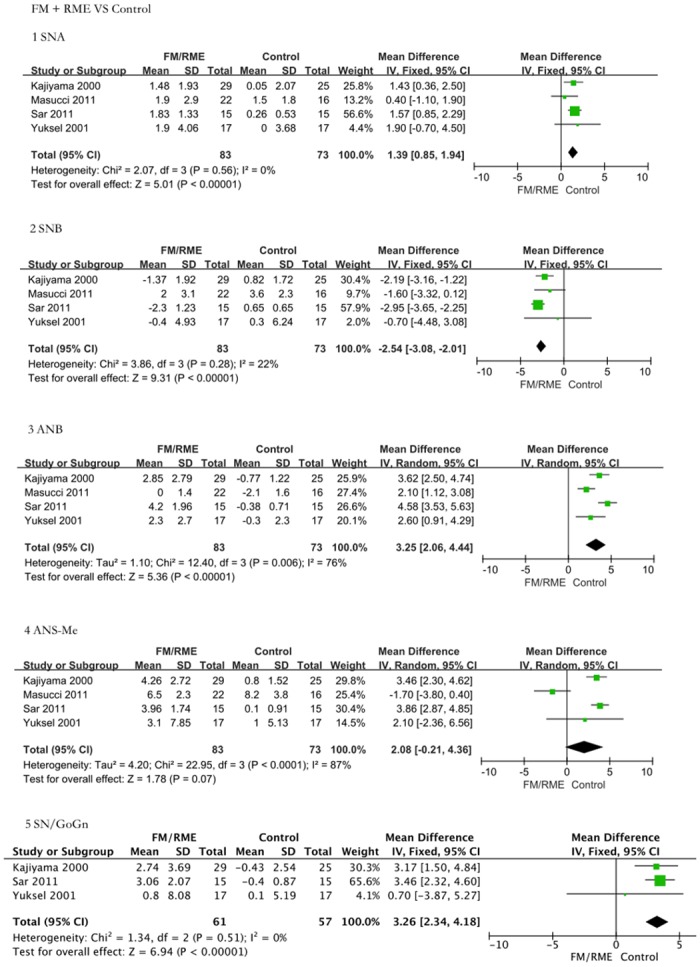
The efficacy assessment of FM/RME treatment for Class III malocclusion versus untreated controls.The comparison was performed using five indices. 1: Angle SNA. The FM treatment group presented a greater increase in SNA than the controls (SMD = 1.39, 95% CI = 0.85–1.94, P < 0.00001). 2: Angle SNB. The FM treatment group presented a greater decrease in SNB than the untreated controls (SMD = -2.54, 95% CI = -3.08–-2.01, P < 0.00001). 3: Angle ANB. The FM treatment group presented a greater increase in ANB than the controls (SMD = 3.25, 95% CI = 2.06–4.44, P < 0.00001). 4: ANS-Me length. The FM treatment group presented a greater increase in ANS-Me length than the controls (SMD = 2.08, 95% CI = -0.21–4.36, P = 0.07). 5: Angle SN/GoGn. The FM treatment group presented a greater increase in SN/GoGn than the controls (SMD = 3.26, 95% CI = 2.34–4.18, P < 0.00001). The FM/RME groups exhibited significant improvement in skeletal retrognathism of the maxilla.